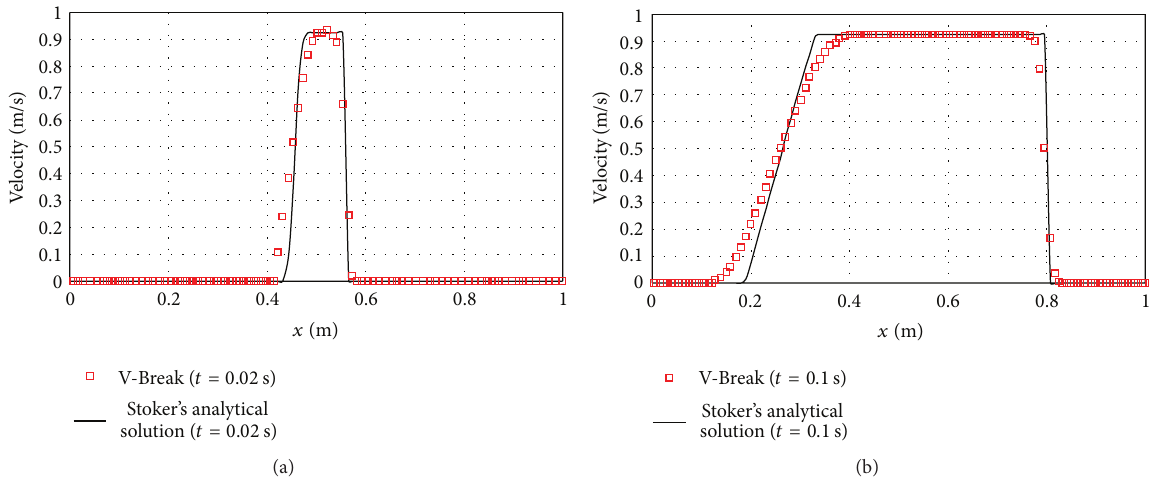
Figure 5: 1D Velocity values obtained using V-Break and stoker’s analytical solution. (a) Velocities at 𝑡 = 0.02 s, (b) velocities at 𝑡 = 0.1